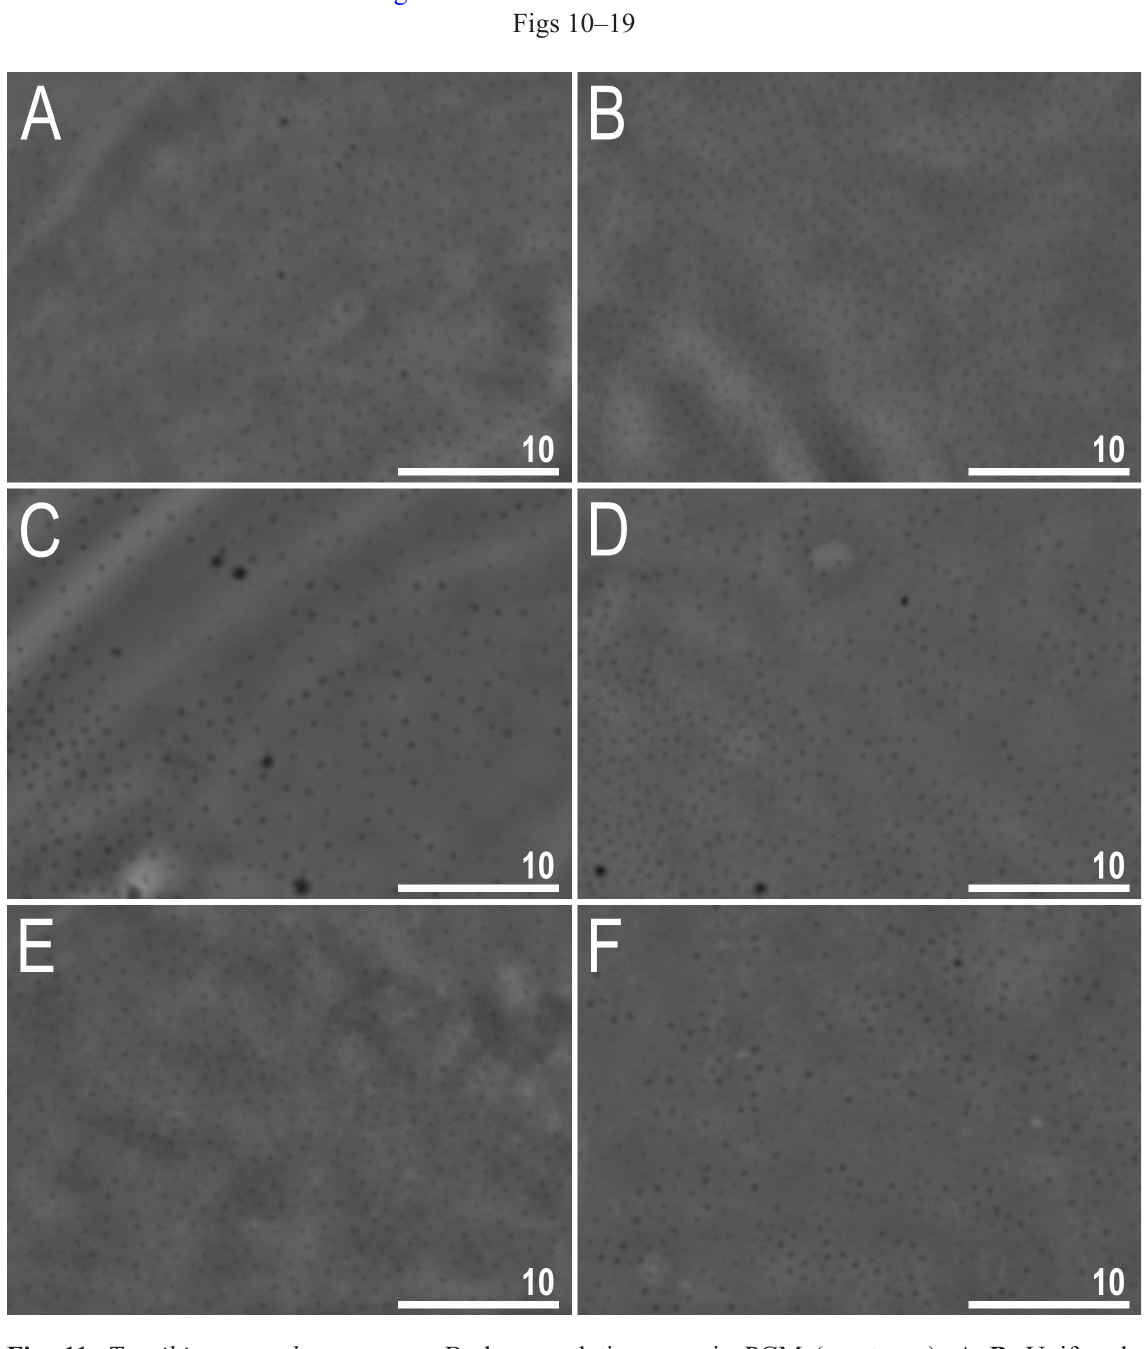
Fig. 11. Tenuibiotus zandrae sp. nov. Body granulation seen in PCM (paratypes). A – B . Uniformly distributed granulation on the dorso-cephalic and dorso-caudal part of the body. C – D . Uniformly distributed granulation on the dorso-cephalic and dorso-caudal part of the body with small, random patches of lacking granulation. E – F . Uniformly distributed granulation on the ventral side of the body without and with small random patches lacking granulation, respectively. A–B, E and C–D, F are from two different paratypes. Scale bars in